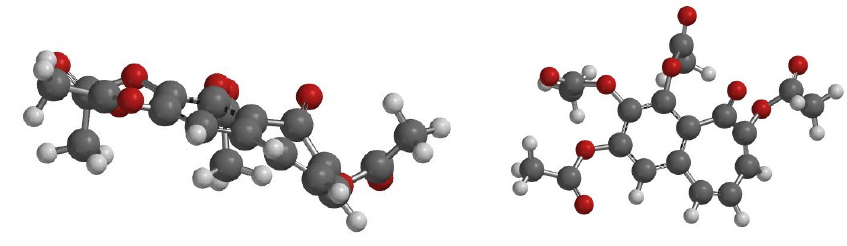
Figure 4. Structure of Tetraacetylpurpurogallin (2) after minimisation.